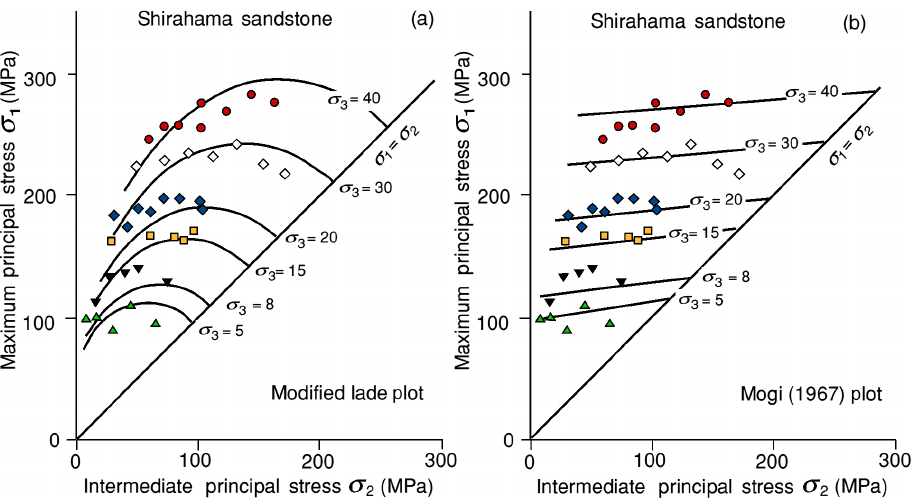
Figure 13. Polyaxial stress data at failure for Shirahama sandstone (Takahashiu and Koide, 1989) fitted by Colmenares and Zoback (2002) to the modified Lade criterion (a) and the Mogi (1967) empirical criterion (b) , contoured for the specific σ 3 values shown. The data do not discriminate well between the two criteria, but the Mogi (1967) criterion predicts higher differential stresses for axisymmetric extension, which demonstrates the utility of constraining fits with axisymmetric extension